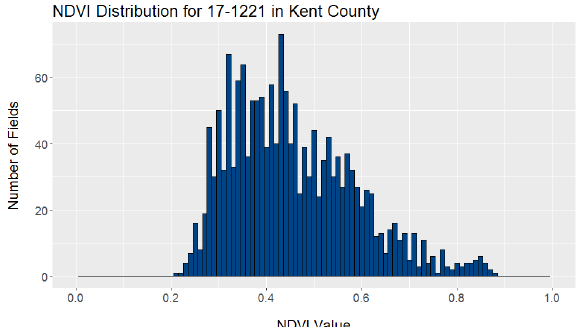
Figure 6. NDVI histogram of enrolled fields in Kent County, Landsat imagery on December 21, 2017. Date is displayed as YY-MMdd.